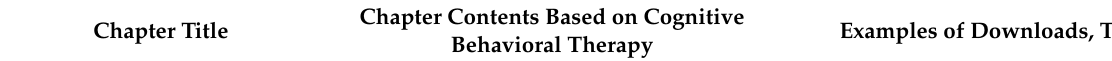
Table 1. Titles and contents of the eight chapters of the me@JGU